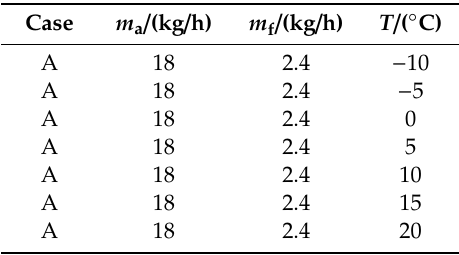
Table 3. Experiment conditions.